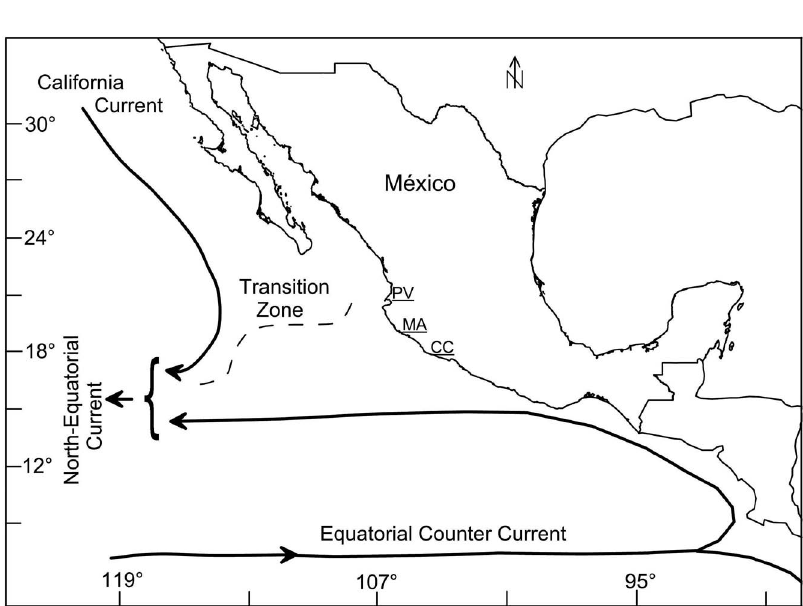
Fig . 1. – Sampling locations in the Tropical Pacific of Mexico: Puerto Vallarta, Jalisco (PV), Manzanillo, Colima (MA) and Caleta de Cam- pos, Michoacán (CC). Oceanic currents with influence in Mexican seas (from Fernández et al. 1992).